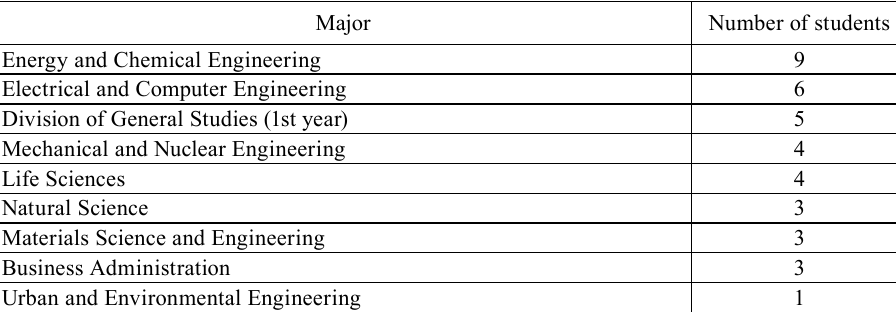
Table 2. Description of student participants (created by